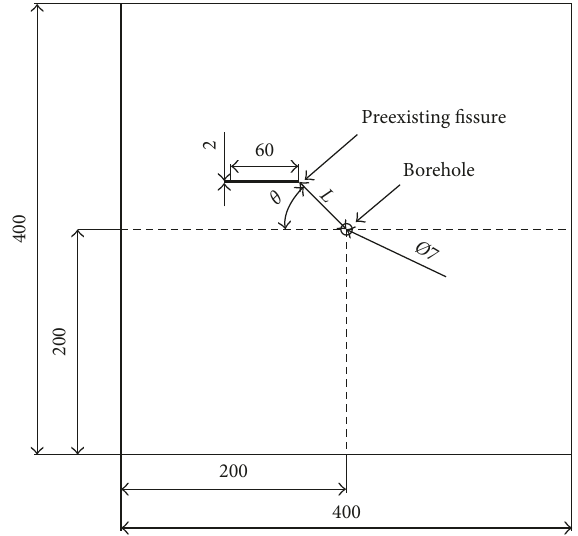
Figure 1: PMMA specimen (unit: mm). Table 1: The variables of the